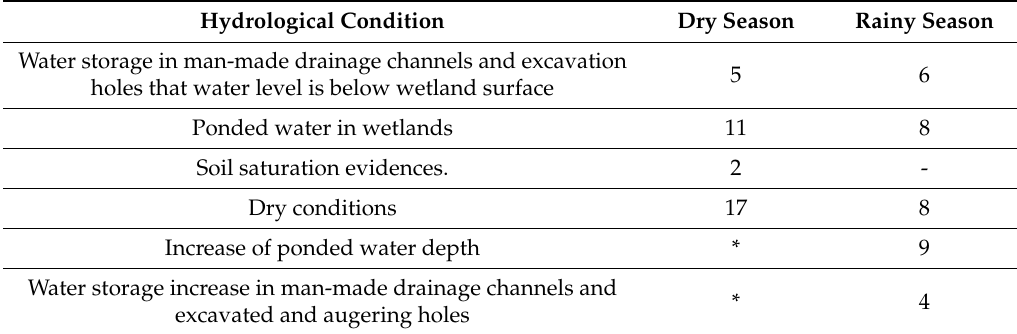
Table 4. Hydrological conditions of monitored wetlands before and after a rainy period.